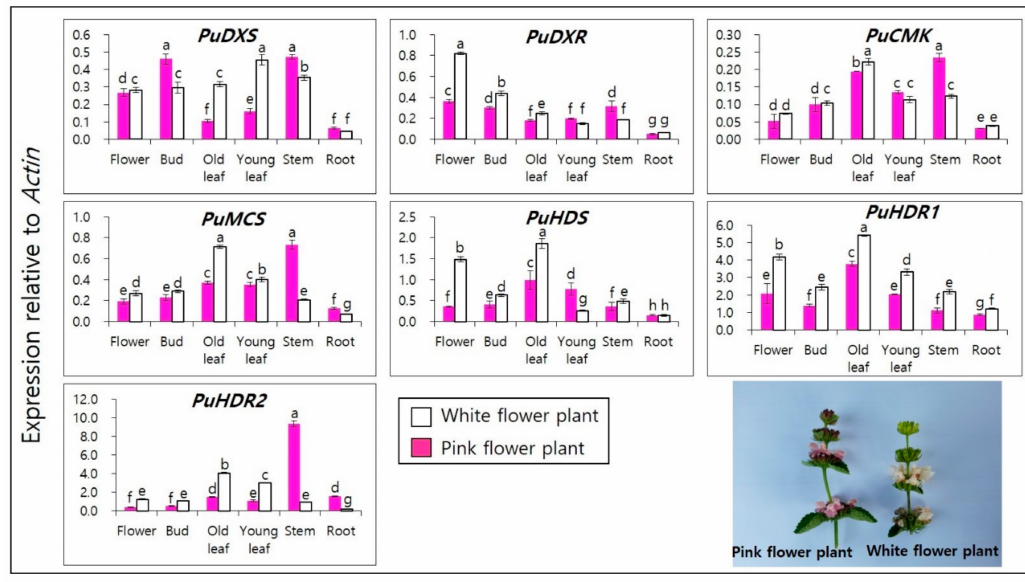
Figure 1. Expression levels of PuDXS , PuDXR , PuCMK , PuMCS , PuHDS , and PuHDRs in the flowers, buds, leaves (old and young), stem, and root of P. umbrosa . The height of each bar and the error bars show the mean and standard error, respectively, from three independent measurements. The values indicate means ± SD. Means with di ff erent letters are significant at p < 0.05 by Duncan’s Multiple Range Test